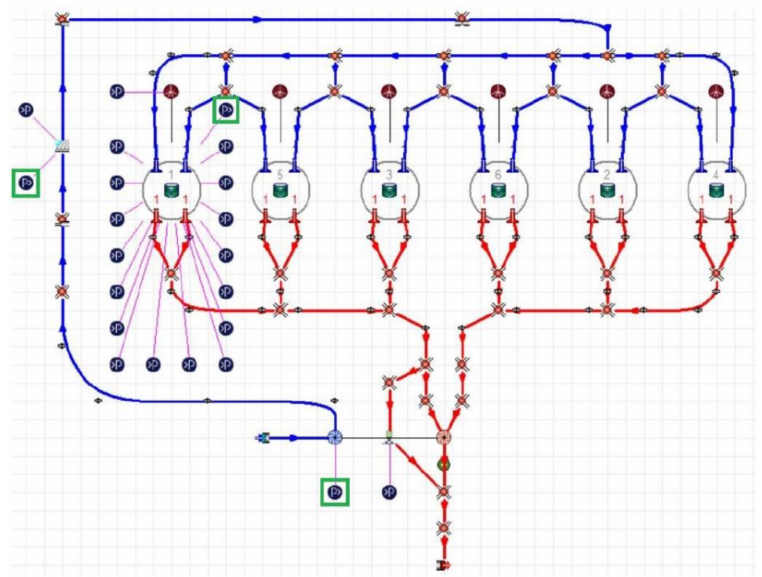
Figure 3. Gasdyn 1D schematic of the 6-cylinder, turbocharged Diesel engine investigated in this study. The “CoSim” input/output objects are clearly visible; “CoSim” input ports are represented in blue circular elements, whereas the “CoSim” output ports are highlighted in green.